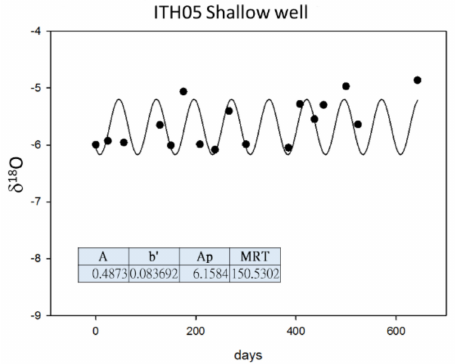
Figure 8. The mean residence time estimation for the shallow well, ITH05, 160 m, with fitting information. A is the seasonal amplitude of δ 18 O for groundwater, Ap is the seasonal amplitude of δ 18 O for precipitation, and b’ is a conversion